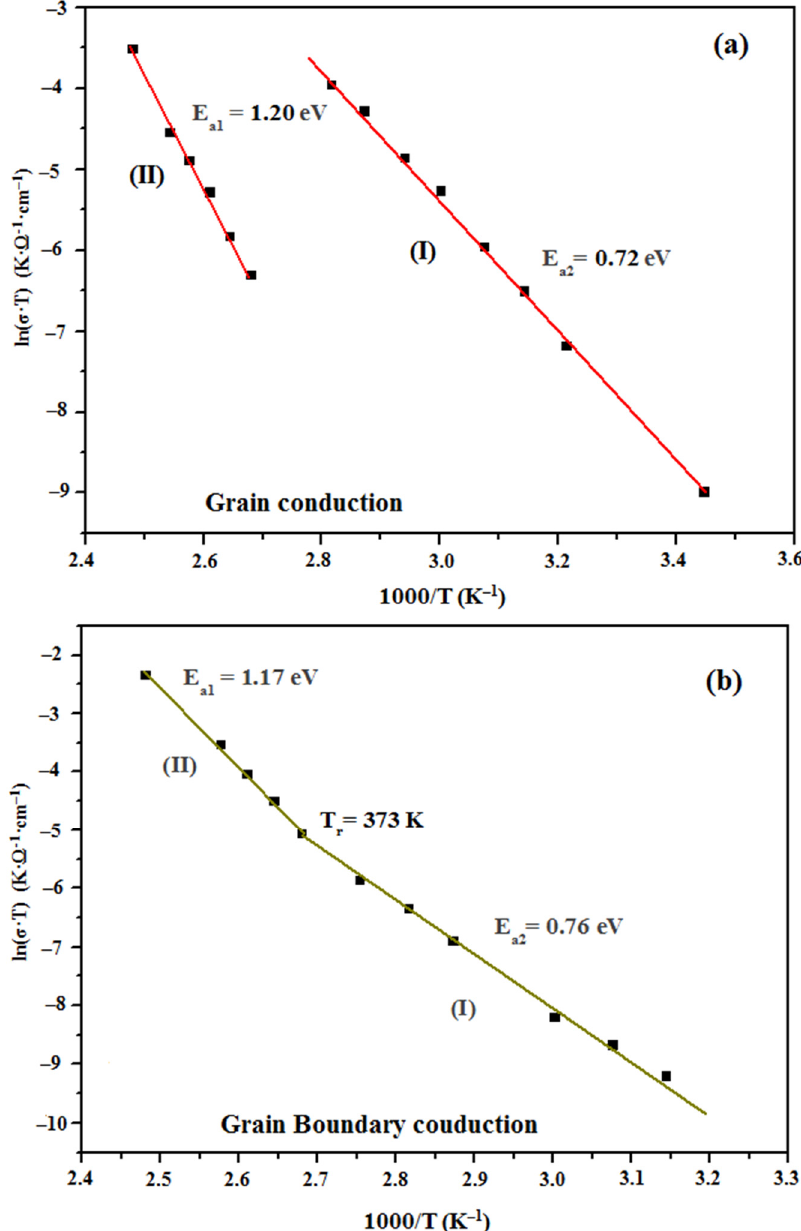
Figure 15. ( a ) Ln ( σ .T) versus 1000/T for (C 5 H 14 N 2 )[HgCl 4 ] · H 2 O in the grain conduction; ( b ) Ln ( σ .T) versus 1000/T for (C 5 H 14 N 2 )[HgCl 4 ] · H 2 O in the grain boundary conduction. Such as the first part ( I ) is located in the region of temperatures below 363 K, while the second part ( II ) is placed in the region of temperatures above 373 K.